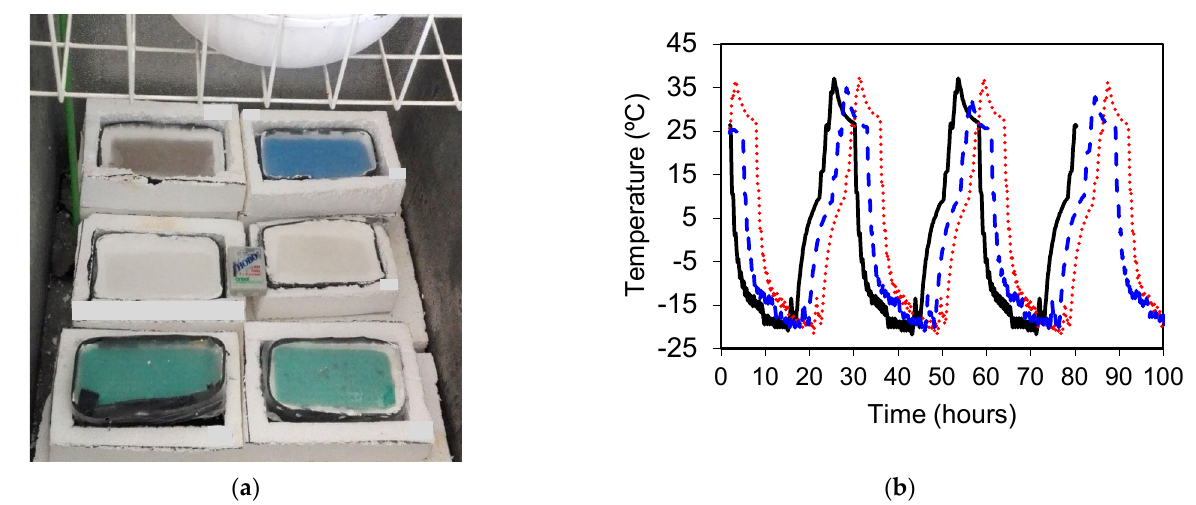
Figure 1. ( a ) Freeze-thaw resistance test setup and ( b ) freeze-thaw temperatures of 3 different cycles.